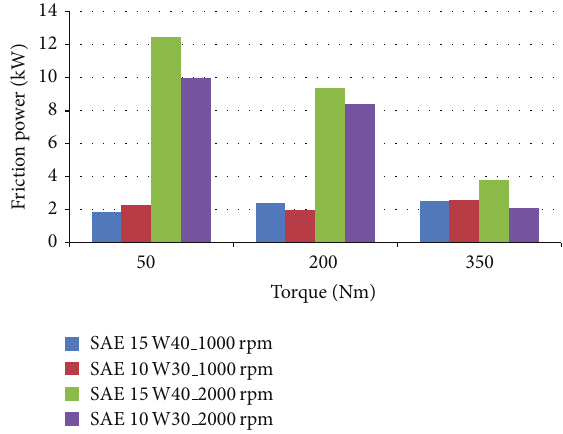
Figure 6: Comparison of friction power at different load and